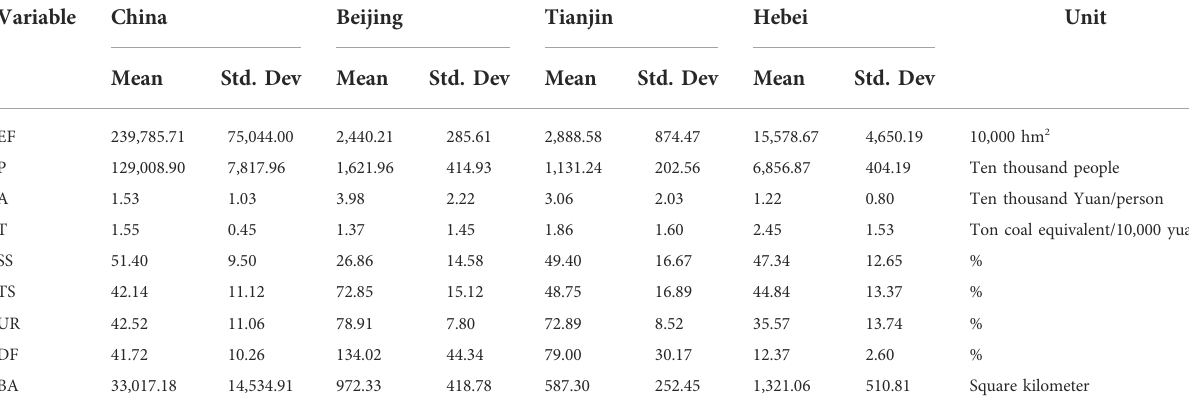
Data source: China, Beijing, Tianjin, Hebei statistical yearbook.